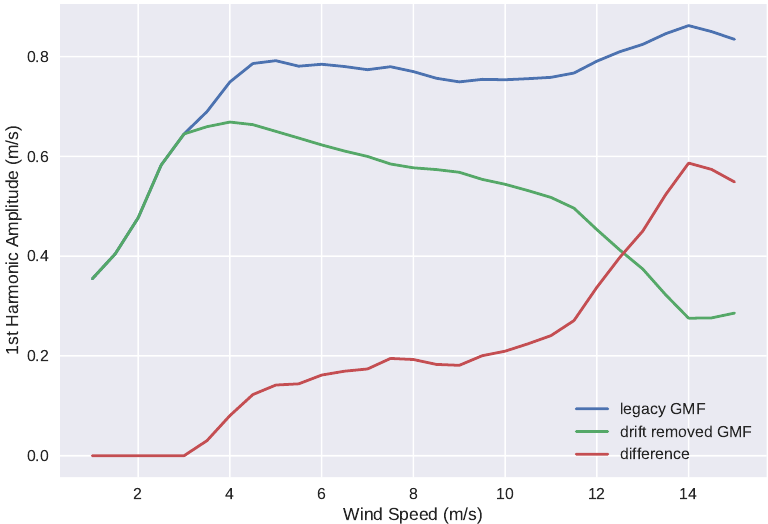
Figure 15. (blue) Magnitude of term in the legacy ECGMF, F CE , proportional to cos φ r , which includes the drift current contribution. (green) Updated CGMF which removes the estimated drift velocity contribution, estimated as a function of measured wind speed. (red) Difference between the two